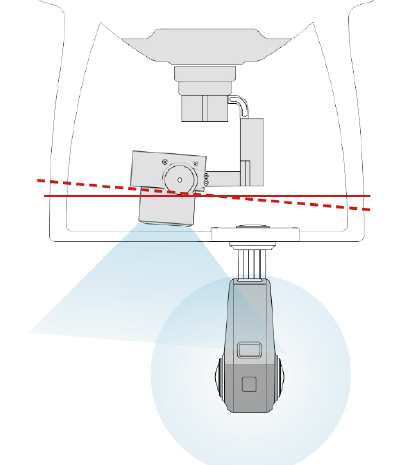
Figure 8. Orthophoto and meshes generated using frame images (top), 360° images (middle) and frame + 360° images (bottom).